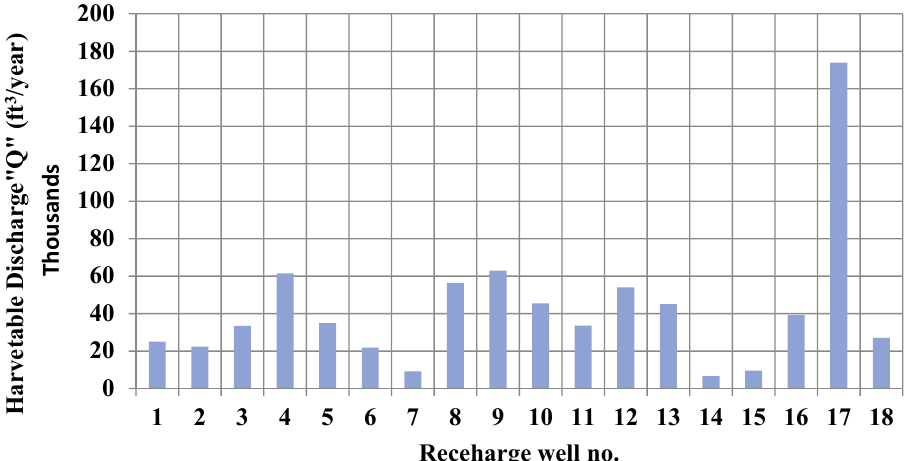
Figure 11. Harvestable water from each recharge well “Q” (ft 3 /year).